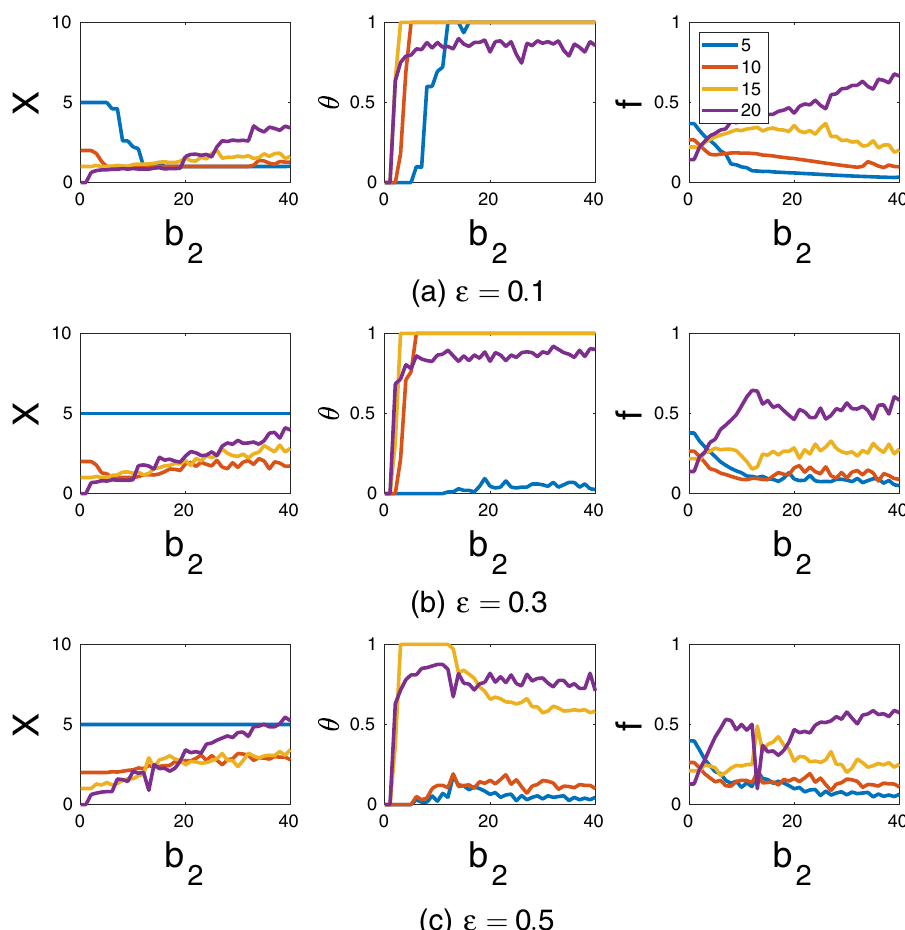
Figure 5. Effects of the benefit parameter b 2 and the incumbency parameter ε on the average number of contributing individuals X , the average cooperation status θ and average power f of each group. Groups with 5, 10, 15 and 20 individuals are considered. Baseline parameters: B 1 = 100 , α = 1 , c = 1 , π 0 = 1 , X 0 = 5 , Z 0 = 50 , µ 1 = µ 2 = 0.25 . The figures show the averages based on 200 runs each of 4000 time steps for each parameter combination. Results in each run are averages based on the last 1000 time